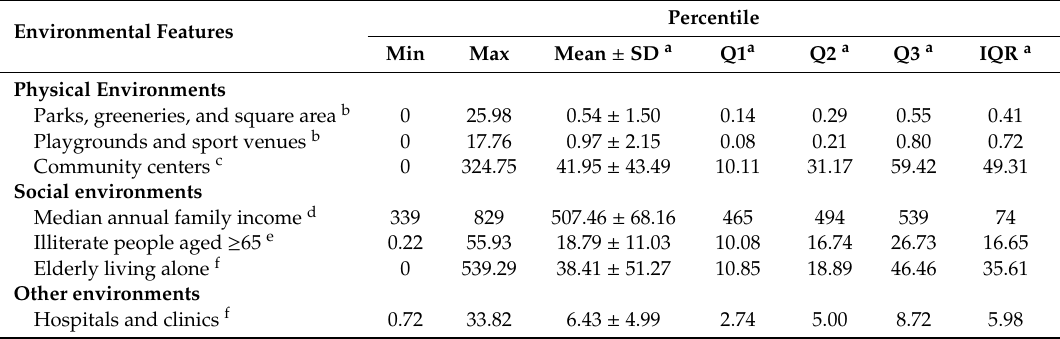
Table 2. Descriptive statistics of environmental features in the residential township (n = 346) of the study subjects.